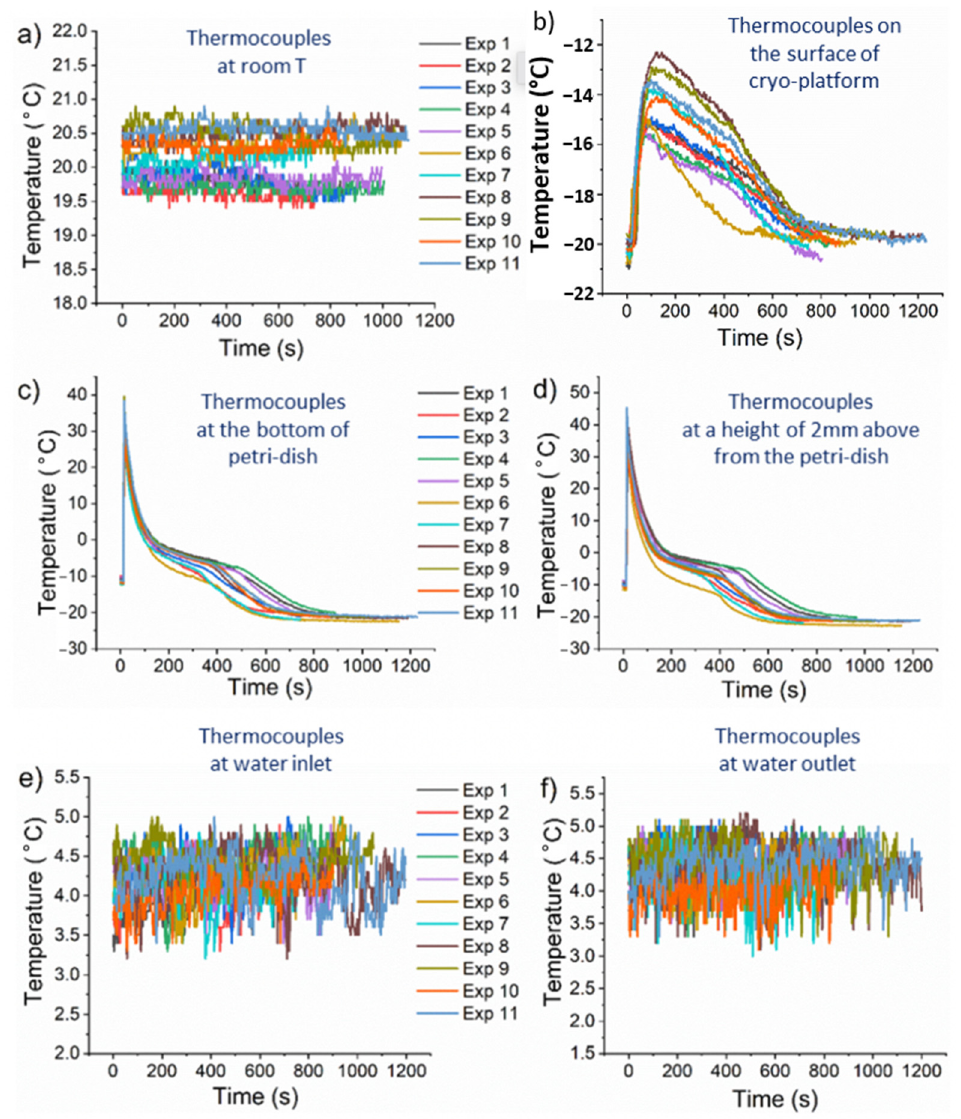
Figure 3. Experimental results of the cooling on the cryoplatform with the Gel-10% solution (different line colors represents 12 reproducible experiments. The cooling kinetics of ( a ) thermocouples at room temperature; ( b ) thermocouples on the surface of the cryoplatform; ( c ) thermocouples at the bottom of the Petri dish; ( d ) thermocouples at a height of 2 mm above the Petri dish; ( e ) thermocouples at the water inlet (water from the chamber); ( f ) thermocouples at the water outlet (water to the chamber).